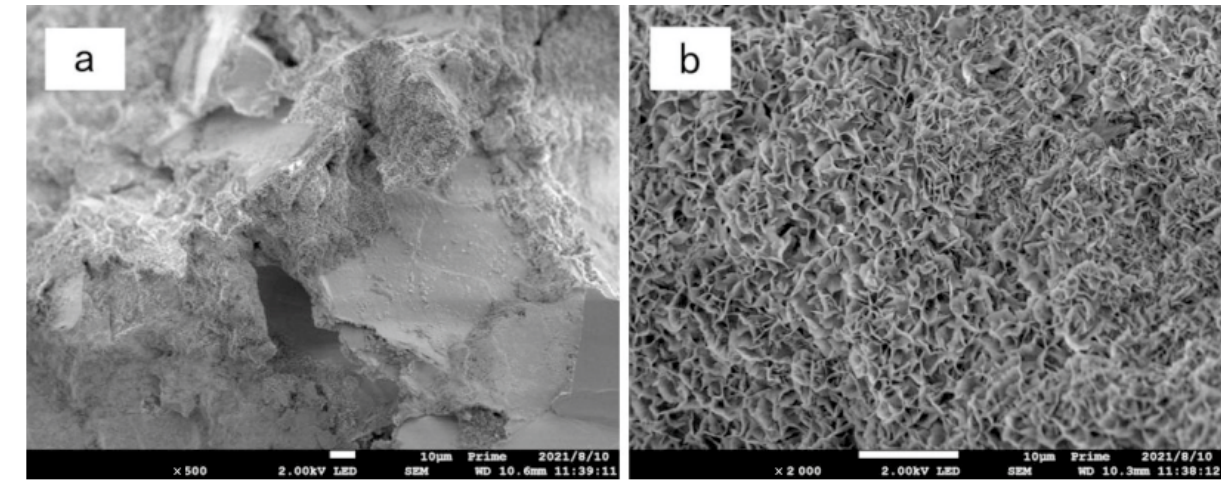
Figure 12. Electron microscopic picture of 12%PVA + 8% active magnesium oxide composite im- provement. ( a ) 500-fold magnified ( b ) 2000-fold magnified